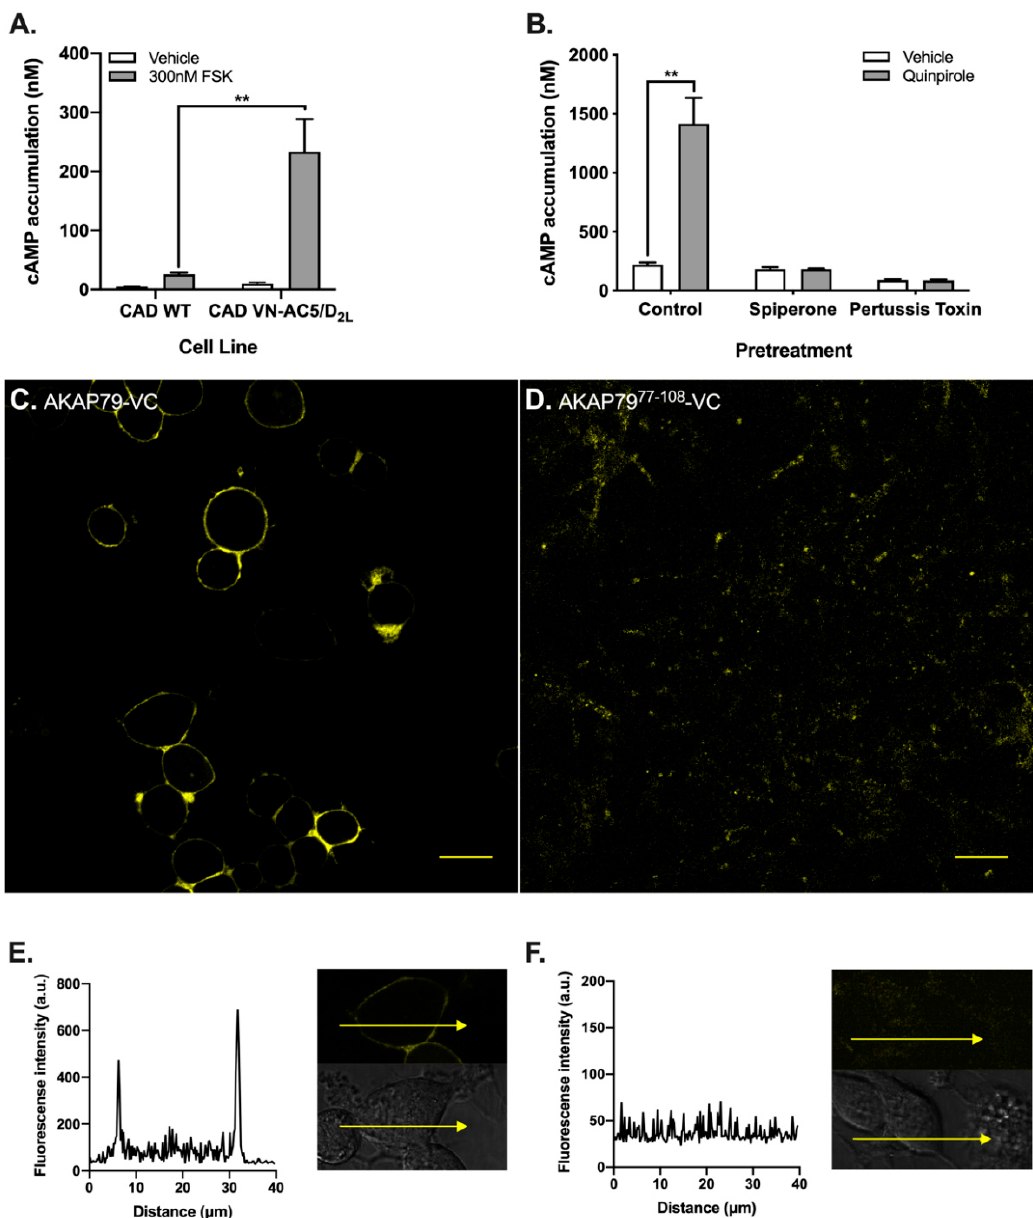
Figure 2. Functional activity profile of Cath a. differentiated (CAD) VN-AC5 / D 2L cell line. Characterization of a stable cell neuronal model co-expressing the D 2L dopamine receptor as well as AC5 fused to the N-terminal BiFC fragment of Venus fluorescent protein (VN-AC5). The cAMP accumulation of the CAD VN-AC5 / D 2L clonal cell line was significantly greater than the parental CAD WT cells following acute stimulation with 300 nM FSK ( A ). The CAD VN-AC5 / D 2L cell line exhibited a 6.5-fold enhancement of cAMP accumulation upon forskolin (300 nM) stimulation following a 4-h treatment with quinpirole (3 µ M) compared with vehicle treatment ( B ). Pretreatment with the D 2 antagonist spiperone or pertussis toxin abolished the AC sensitization response. Statistical analysis (t-test) was performed, ** p < 0.01. Experiments ( n = 3) were performed in duplicate with SEM shown. Positive and negative BiFC controls were used to validate the specificity and fluorescence intensity of the CAD VN-AC5 / D 2L cell line. The 60x confocal images represented the CAD VN-AC5 / D 2L transfected with 1 µ g of ( C ) the positive control AKAP79-VC, where Venus fluorescence was clearly observed localized to the cell membrane or ( D ) the negative control AKAP79 77–108 -VC that exhibited no specific localization. Scale bars = 30 µ m. Line scans of representative cells demonstrate an enhanced membrane-localized BiFC fluorescent signal for cells transfected with AKAP79-VC ( E ), compared with AKAP79 77–108 -VC ( F